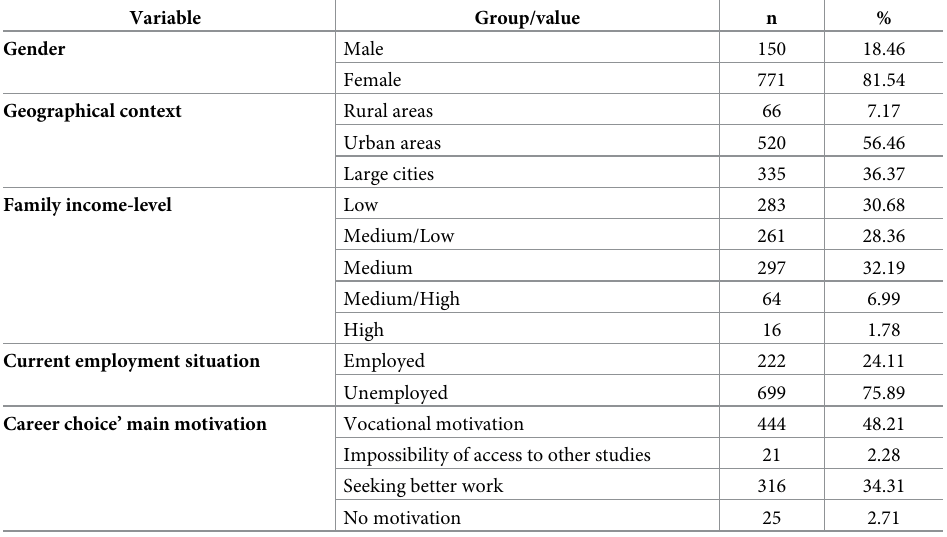
Table 1. Sociodemographic characteristics of the study